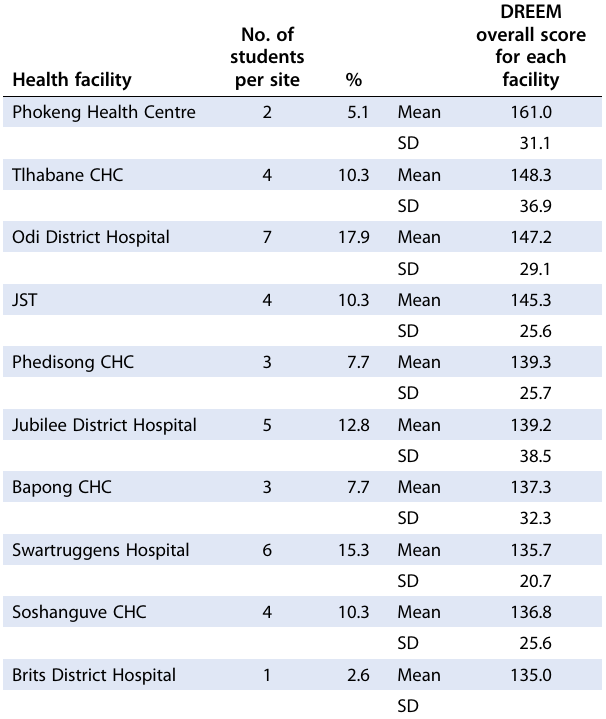
Table 4: Health facility and learning environment